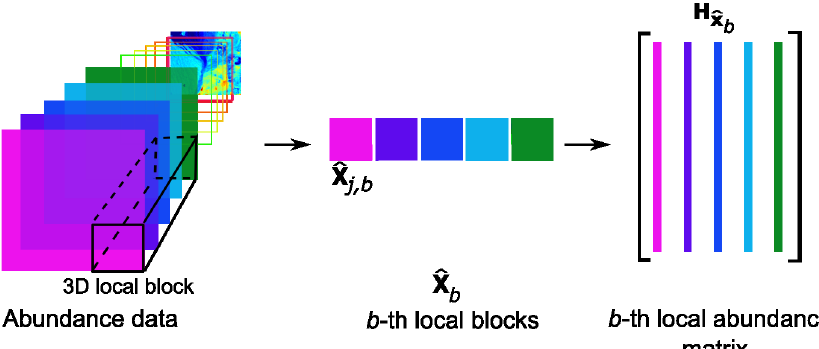
Figure 3. Process of vectorizing and arranging local abundance matrix of hyperspectral